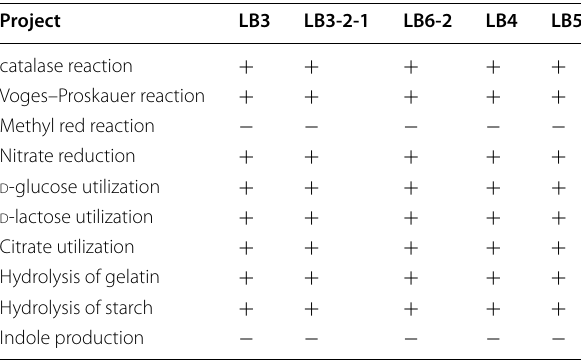
“ ” represents the test results were positive; “ + negative